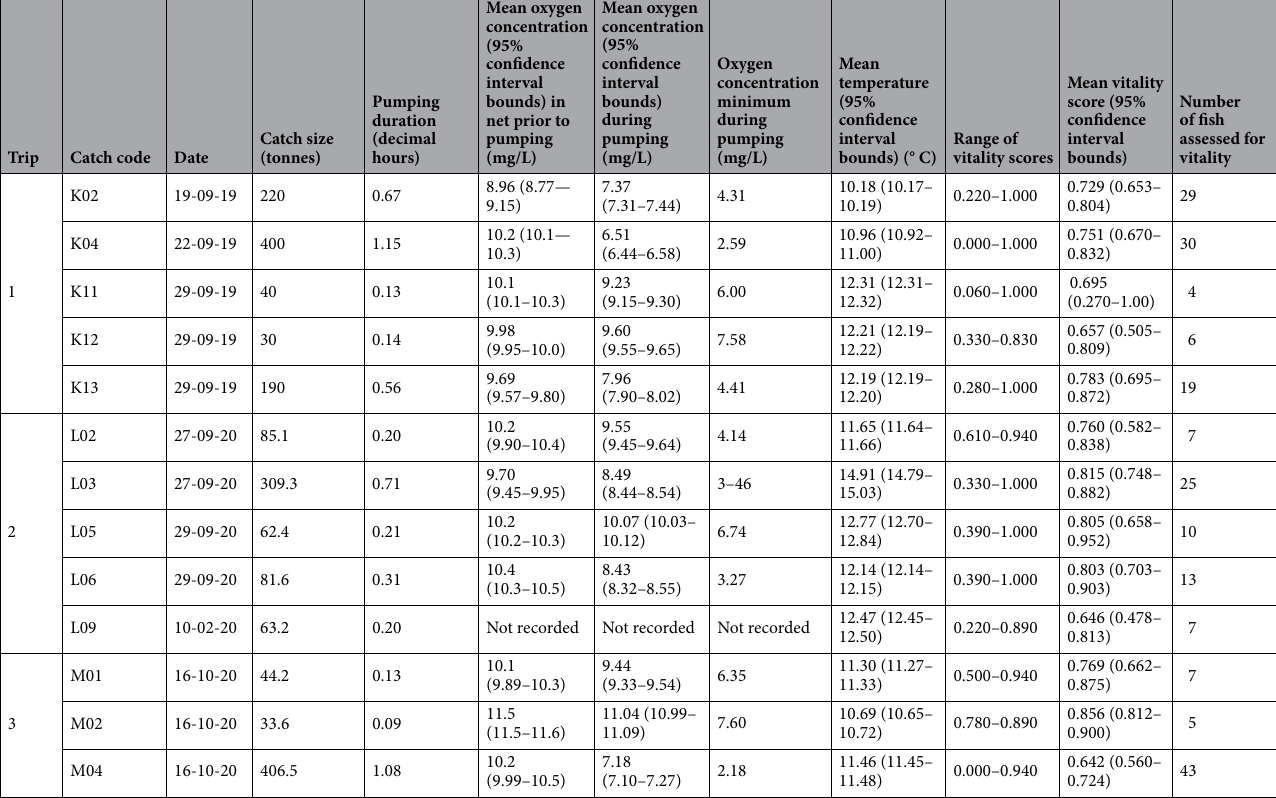
Table 5. Pertinent details of purse seine catches in which the vitality of Atlantic mackerel ( Scomber scrombrus ) was